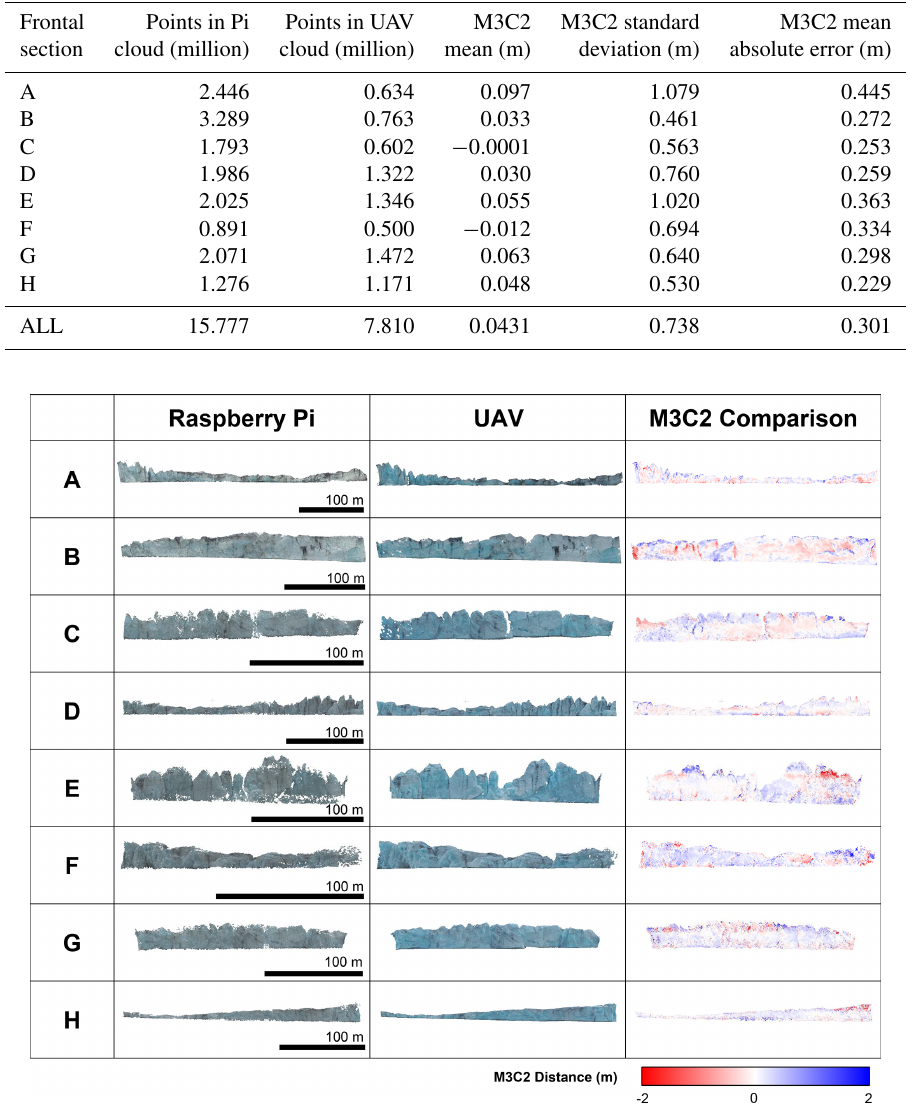
Figure 4. Fjallsjökull calving face running from northernmost (A) to southernmost (H) sections, as captured by the Raspberry Pi and UAV, and the M3C2 distance between each. Note varying scales between each section are to minimize white space in figure